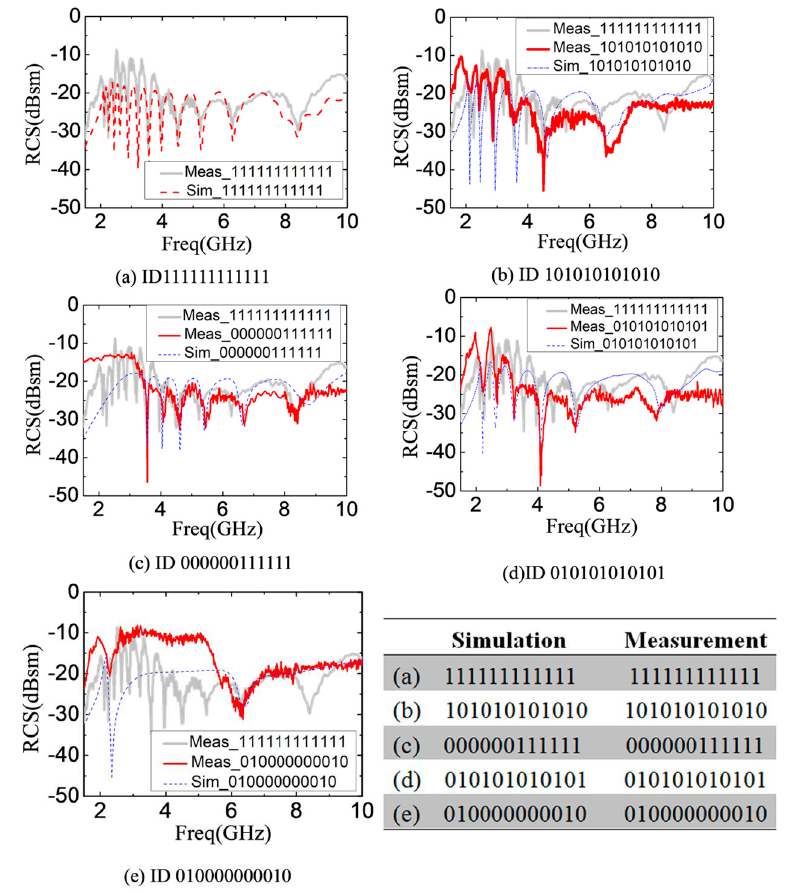
Figure 13. RCS magnitude for twelve Rectangular Slot Rings with ( a ) ID 111111111111 ( b ) ID 101010101010 ( c ) ID 000000111111 ( d ) ID 010101010101 ( e ) ID 0100000010.